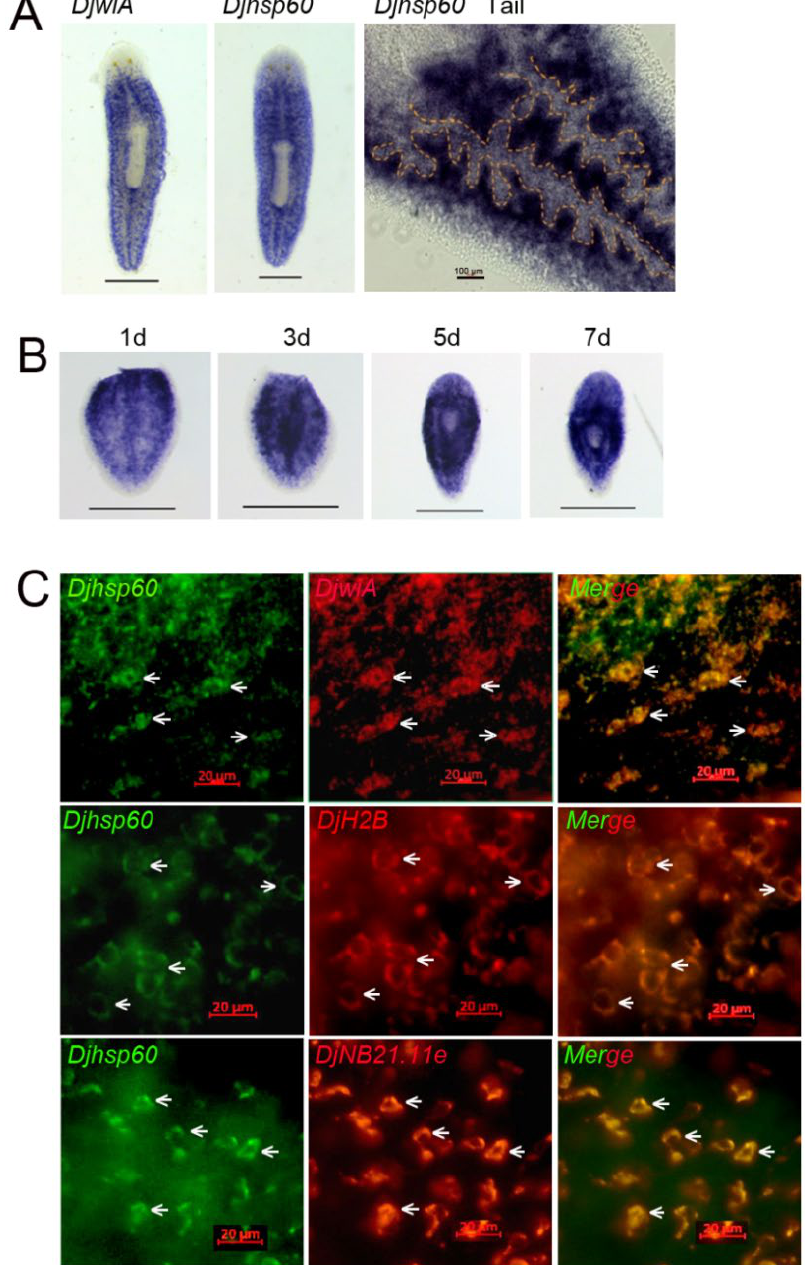
Figure 1. Expression patterns of Djhsp60 . ( A ) Expression patterns of Djhsp60 in intact animals revealed by WISH. The orange dashed line indicates the border between parenchymal tissues and intestinal tissue. n = 6 animals. Scale bar 0.5 mm. ( B ) Expression patterns of Djhsp60 during planarian regeneration revealed by WISH. n = 6 animals. Scale bar 0.5 mm. ( C ) Co-expression of Djhsp60 / DjH2B and Djhsp60 / DjNB21.11e revealed by double-FISH. Arrows indicate the co-expressed cells. n = 5 animals. Scale bar: 20 µm.